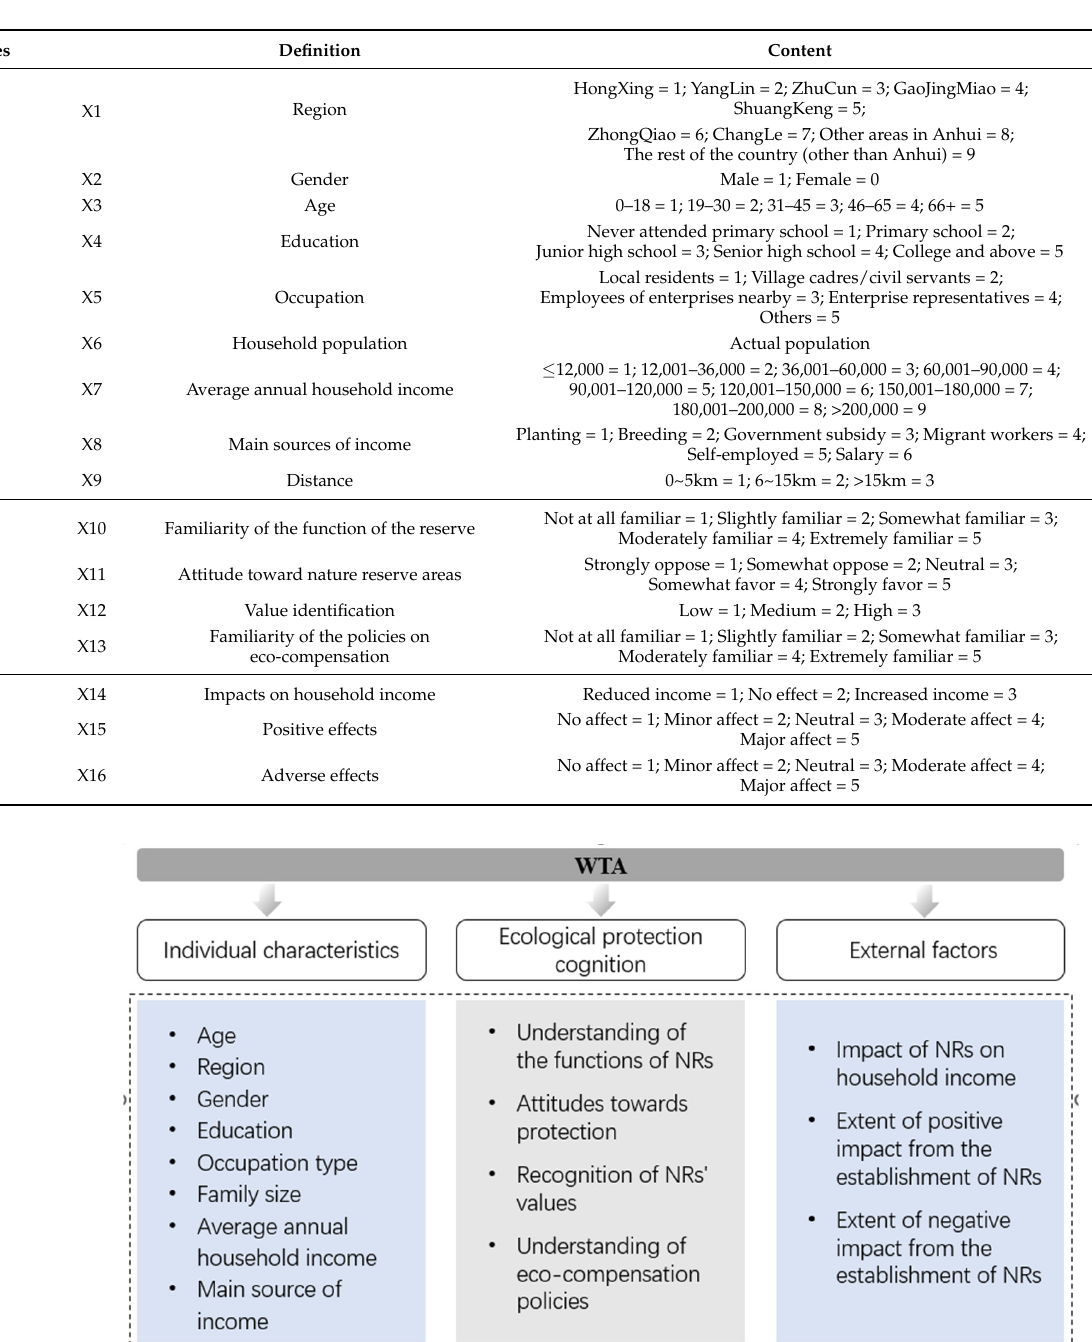
Table 3. Selection and definition of variables.